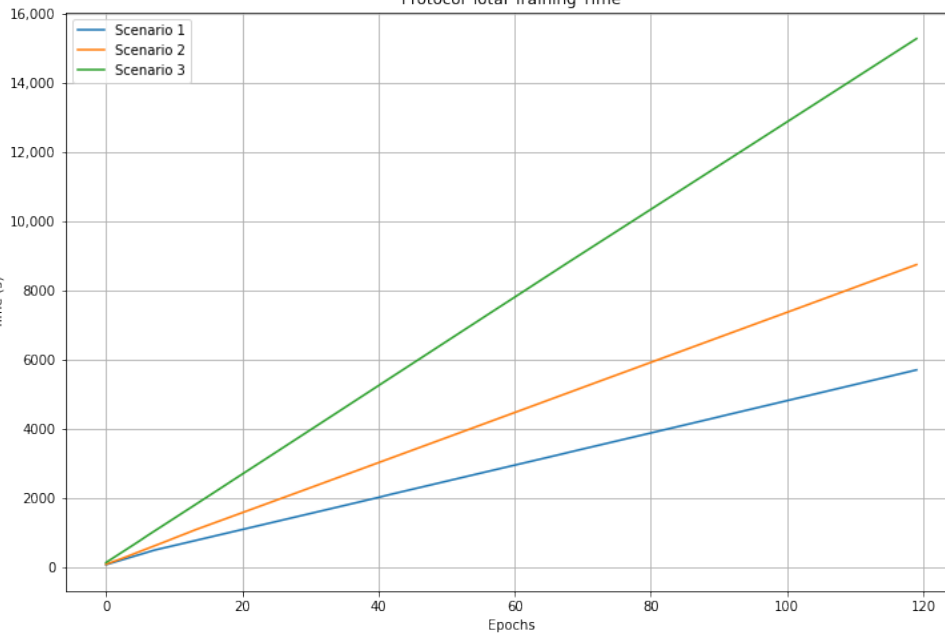
Figure 13. Comparison of the total training times using the